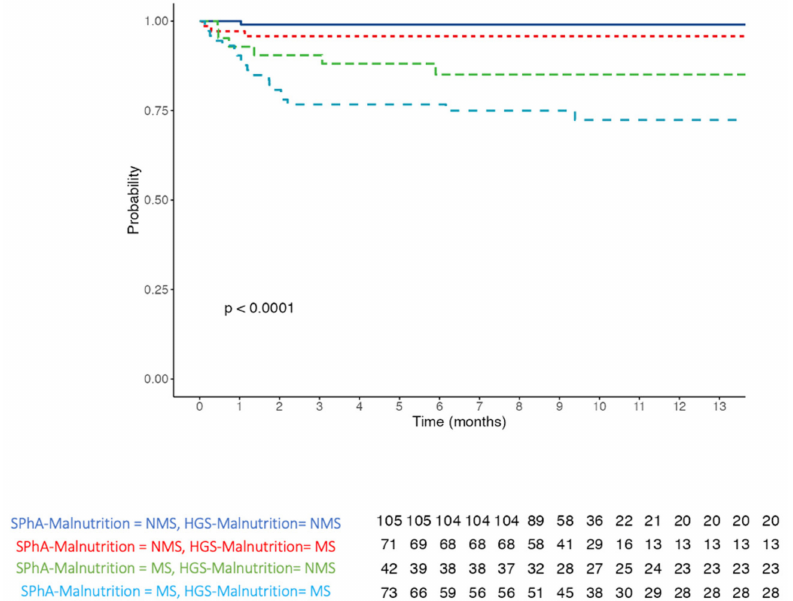
Figure 4. Kaplan–Meier survival curves of patients in groups with low or high SPhA-Malnutrition and HGS-Malnutrition. The table at the bottom indicates the number of surviving patients in each group corresponding to the intervals in the graph. Abbreviations: malnutrition status (MS)—non- malnutrition status